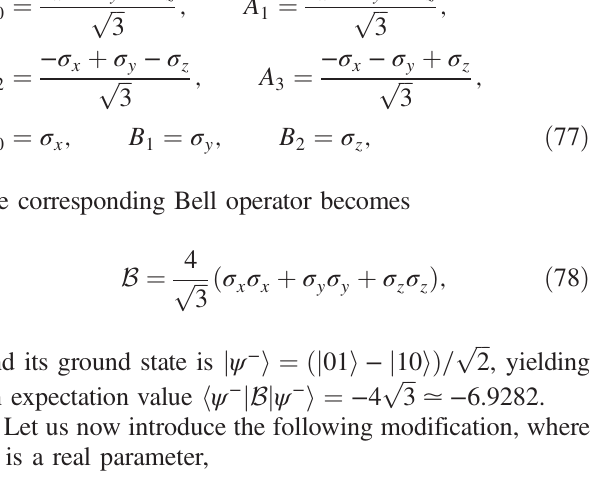
FIG. 6. Ratio of the quantum value over the classical bound of the ground state of Eq. (75) and the Bell inequality we associate to it. The plot corresponds to a spin glass of n ¼ 100 spins with PBC, averaged over 1000 realizations. The horizontal axis corresponds to the mean μ of the Gaussian distribution and the vertical axis corresponds to its standard deviation σ . If μ ¼ 0 , the value is constant for all σ > 0 , as both the expected value of the ground state and the classical bound grow at the same rate with σ . The white line represents the level curve for β top left part of the plot corresponds to the region of parameters in which we detect nonlocality ( β right region one finds values for which β that there is no simultaneous eigenvalue of σ π classical bound cannot be saturated using σ π